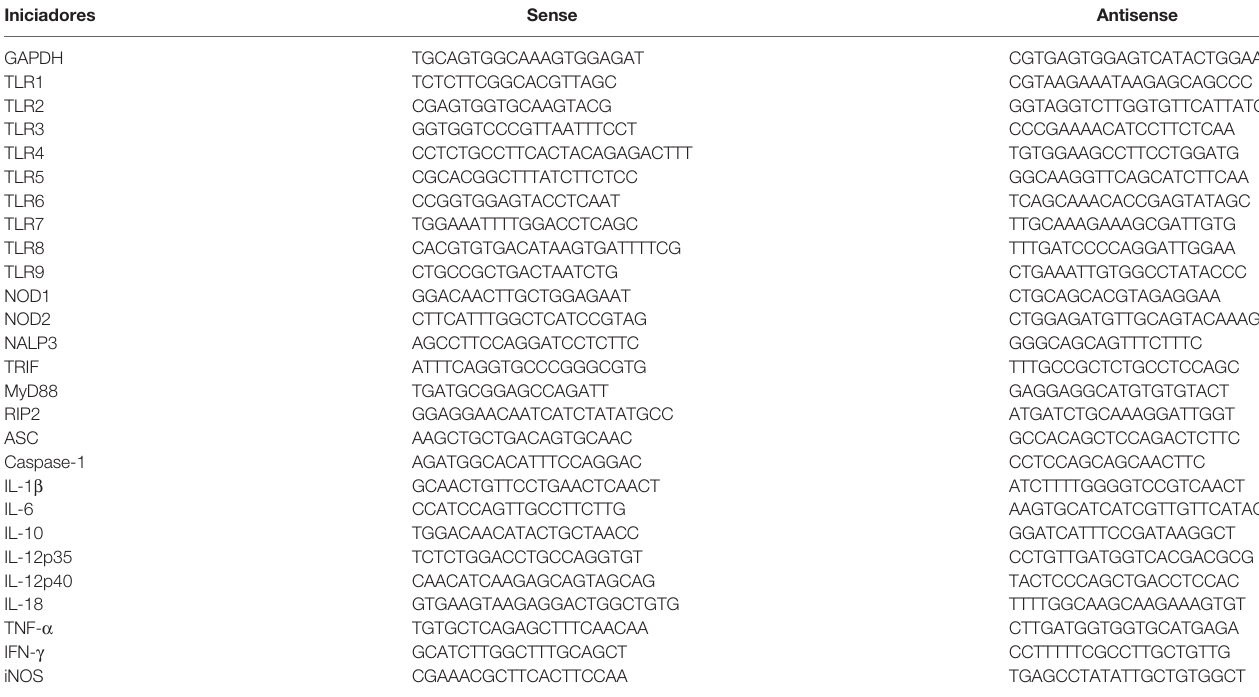
TABLE 1 | Sequence of the used speci fi c starters in the reactions of PCR in real time.